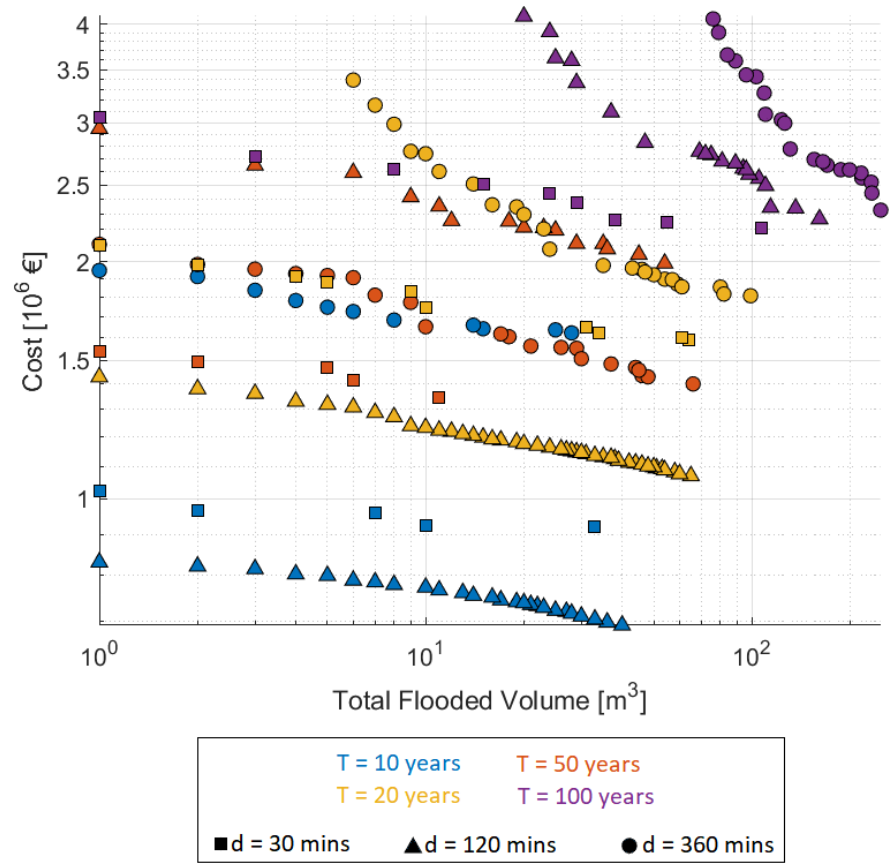
Figure 5. Pareto front for volume reduction vs. costs for SUDS optimization process in 12 different rainfall design events. Color scale for different return periods, and marker shapes for the duration of the events.